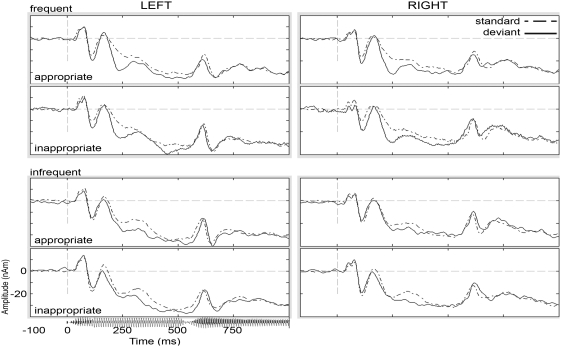
Grand-averaged source waveforms for the experimental odd-ball sequences contrasting frequent/infrequent nasal place feature assimilations embedded in appropriate/inappropriate phonemic context.Robust mismatch activity was present in both hemispheres in all conditions in the interval 170–410 ms following stimulus (shown below the left panel) onset.